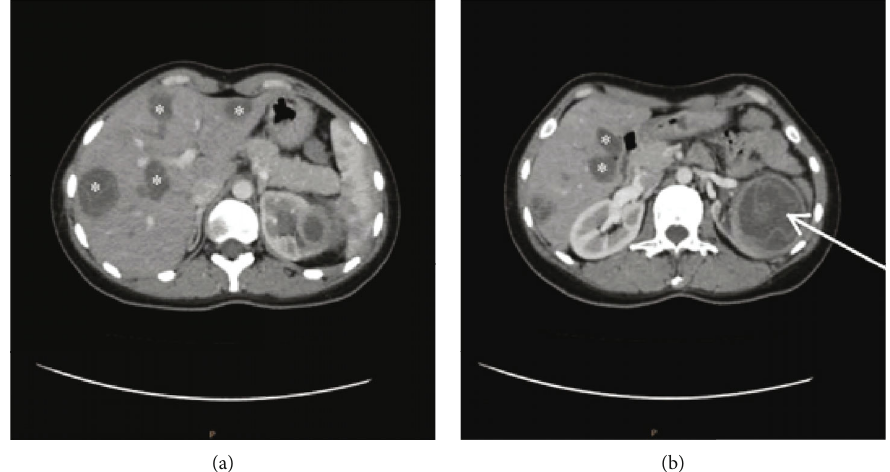
Figure 1: Abdominal CT scan of the patient showing (a) multiple cysts in the liver “ ∗ ” and (b) multiple cysts in the liver “ ∗ ” and a solitary cyst in the kidney “ arrow ”